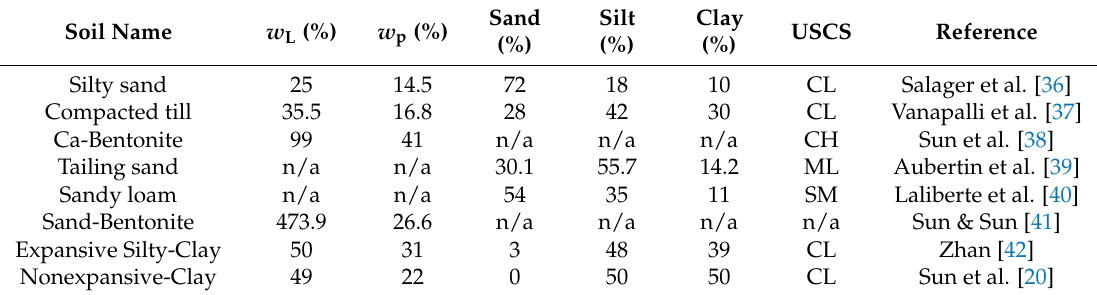
Table 1. Summary of the index and other properties of the investigated